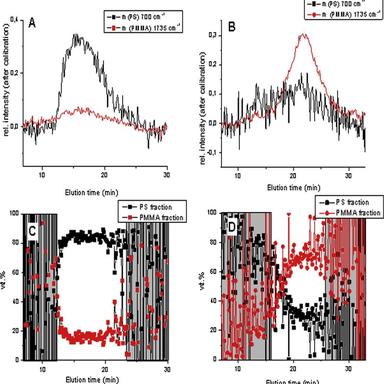
ThFFF-IR elugrams of samples SMA3 (A) and SMA4 (B) after calibration. (C) and (D) show the wt.% fractions of styrene and MMA units in the samples SMA3 and SMA4 as a function of elution time. Experimental ThFFF conditions as in 2.